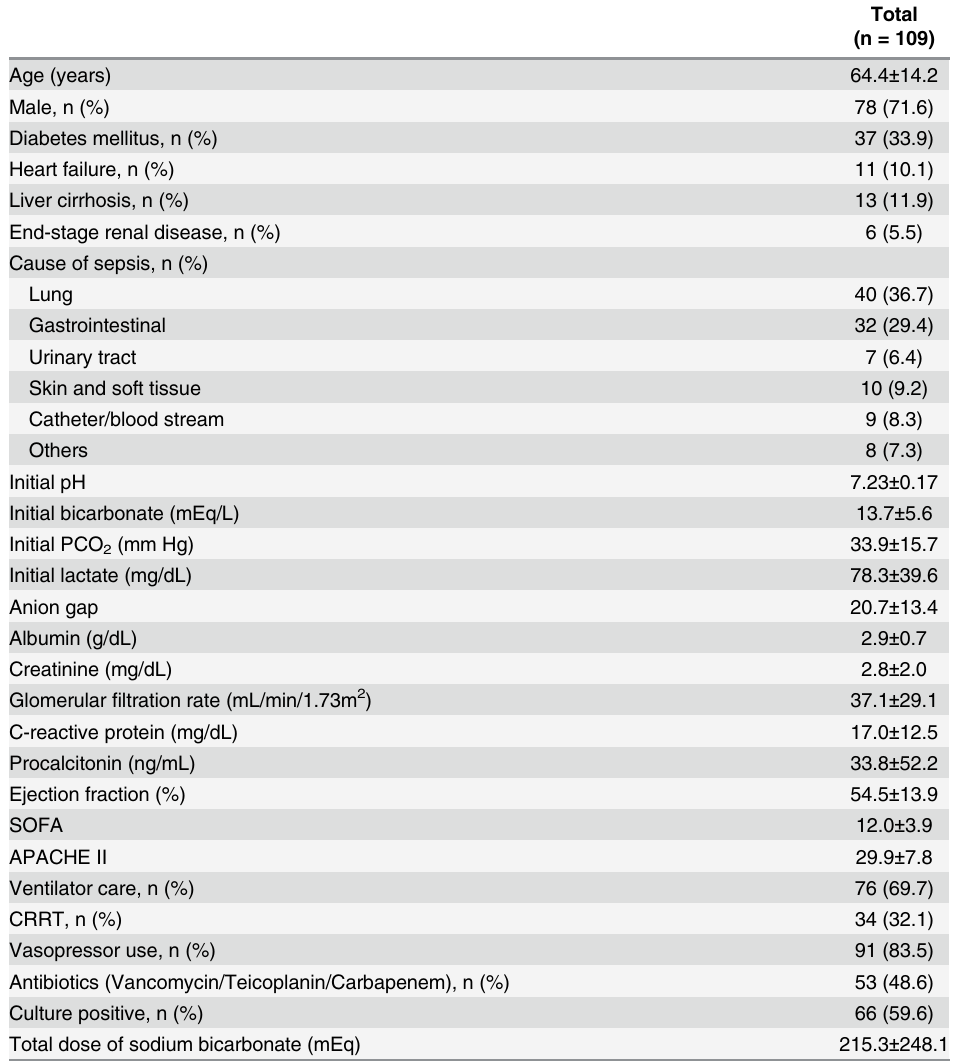
Table 1. Baseline